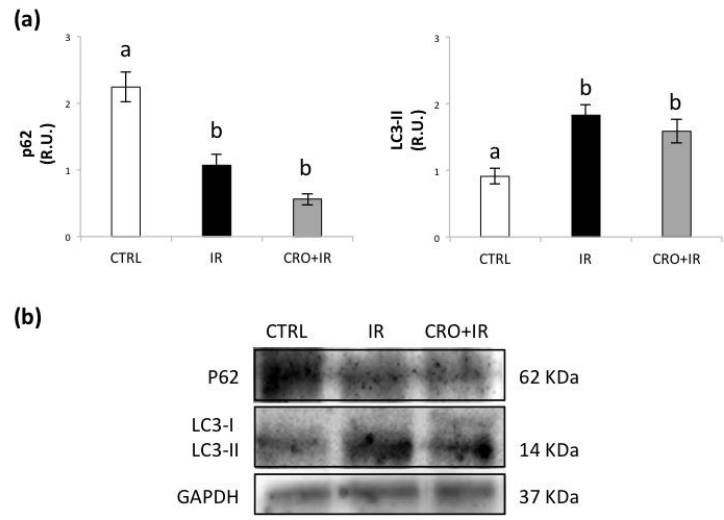
Figure 4. ( a ) Western blot analysis of p62 and LC3-II. ( b ) Representative images of immunoreactive bands. Data are presented as means ± SEM of densitometric analysis of immunoreactive bands normalized to internal reference protein (GAPDH). One-way ANOVA p < 0.05; a,b p < 0.05, Holm– Sidak post hoc multiple comparison.